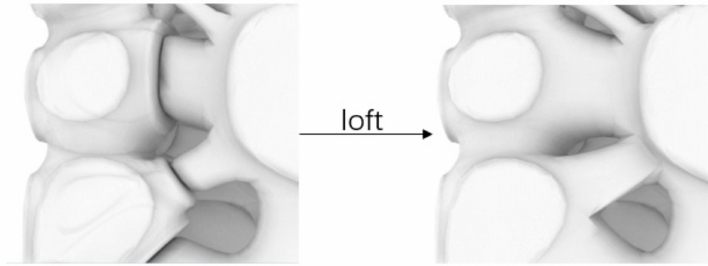
Figure 6. The smooth transition between solid structures after